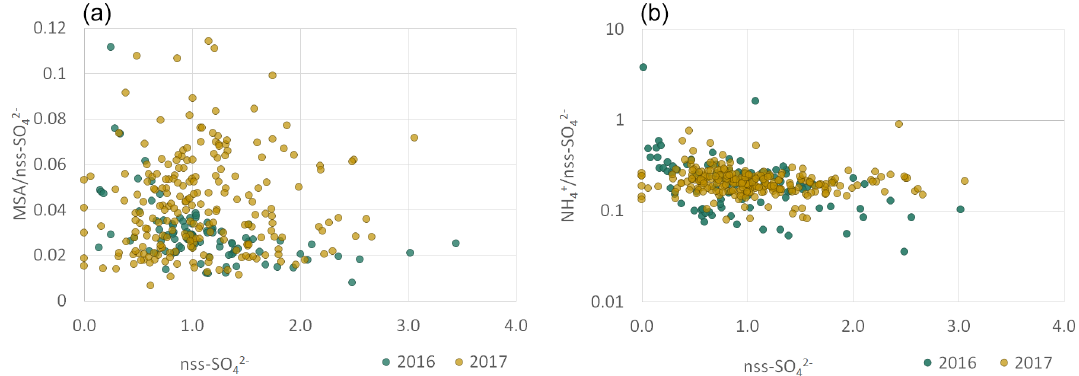
Figure 8. Scatterplots for ratios of MSA (a) and NH + µgm − 3 . Note the logarithmic y axis of the figure in (b)